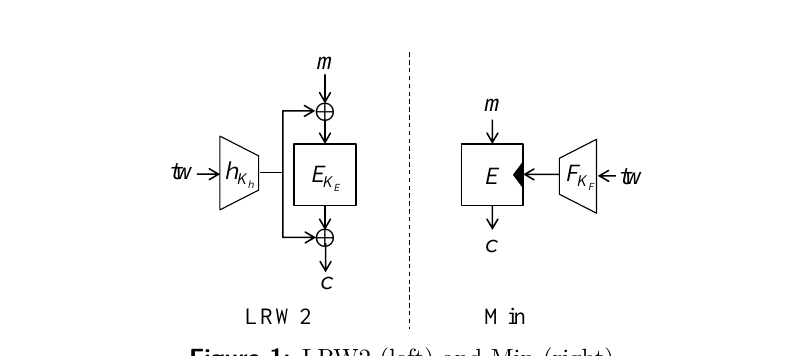
Figure 1: LRW2 (left) and Min